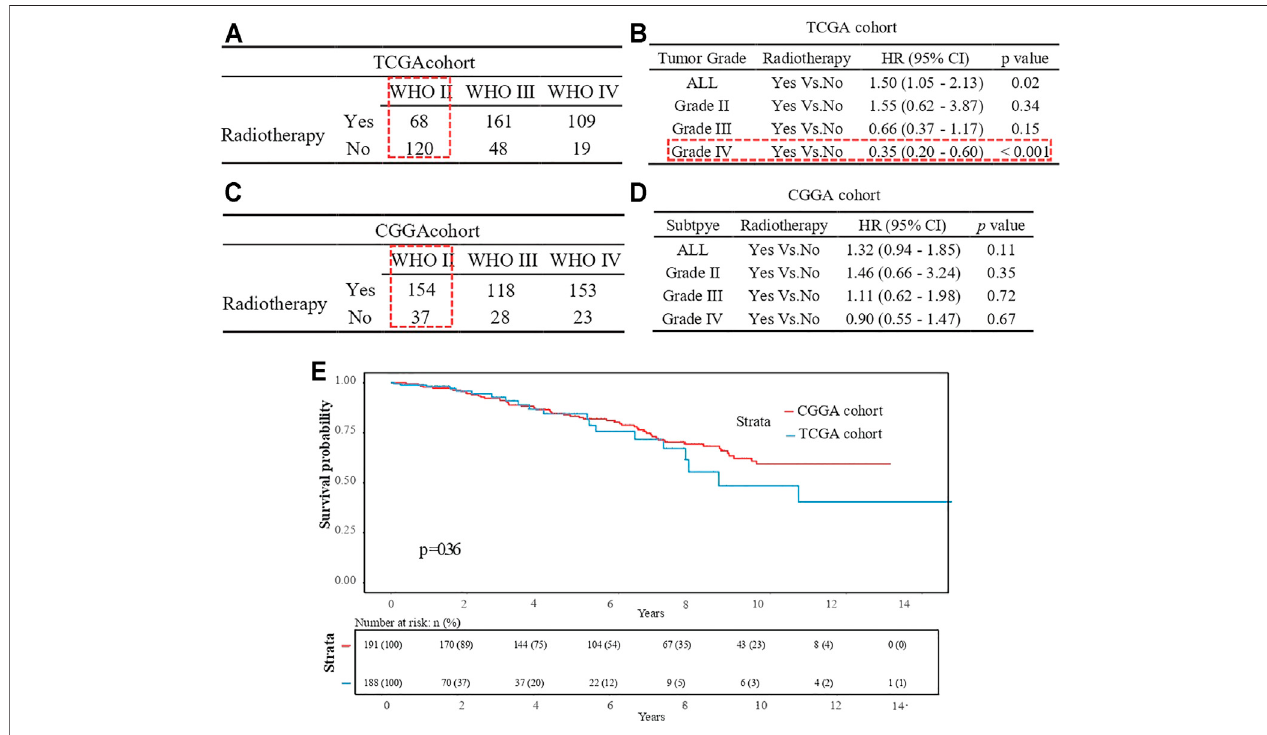
FIGURE 7 | Radiotherapy status comparison for grade III patients. (A) Frequency table in TCGA cohort. (B) Strati fi cation analysis in TCGA cohort. (C) Frequency table in CGGA cohort. (D) Strati fi cation analysis in CGGA cohort. (E) Kaplan-Meier curve for the two cohort patients with tumor grade II.